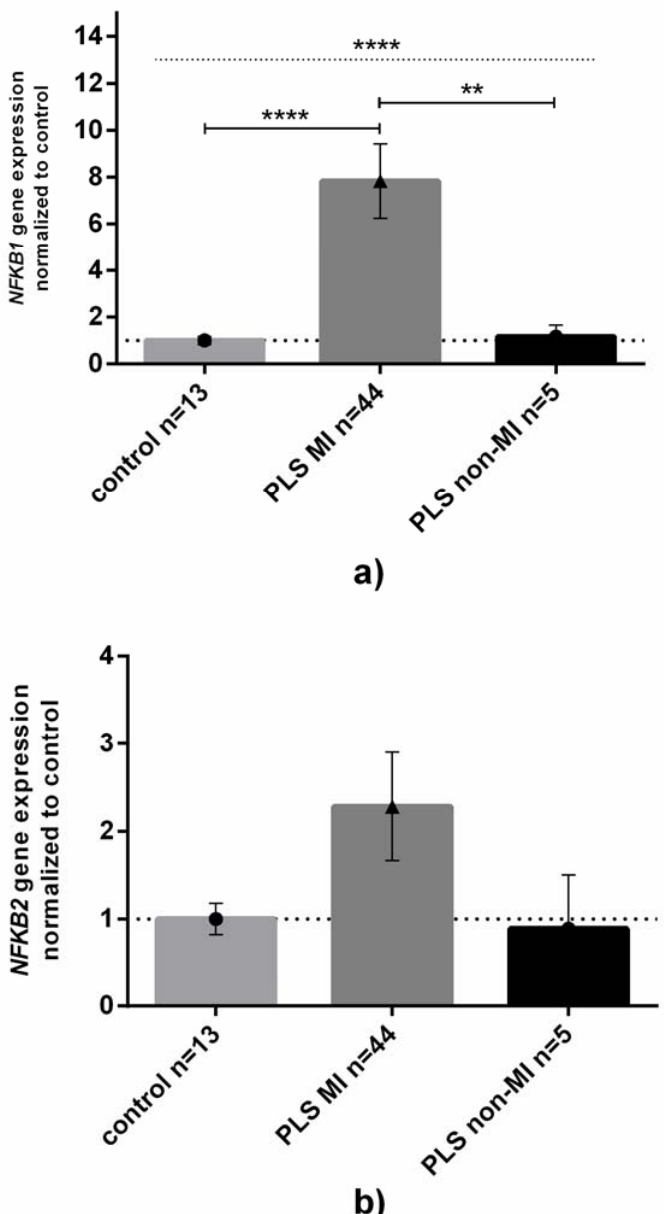
Figure 3. NFKB1 and NFKB2 gene expression levels in penile lichen sclerosus related to the occurrence of micro ‐ incontinence. Gene expression levels of ( a ) NFKB1 or ( b ) NFKB2 in control or inflamed PLS samples were assessed as described in Methods. Bars and whiskers represent the mean ± SD normalized to control foreskin samples (dotted horizontal line at 1) grouped by each analyzed gene. Bar legends: light ‐ grey bars represent control group (none of them had micro ‐ incontinence), dark ‐ grey bars represent patients with micro ‐ incontinence (MI) while black ones represent patients without MI, respectively. ** p < 0.01, **** p < 0.0001 (Mann–Whitney U test between each group, solid line; Kruskal–Wallis ANOVA test between all groups, dotted line) between MI and lack of MI subgroups. Abbreviation: PLS, penile lichen sclerosus, MI, micro ‐ incontinence.